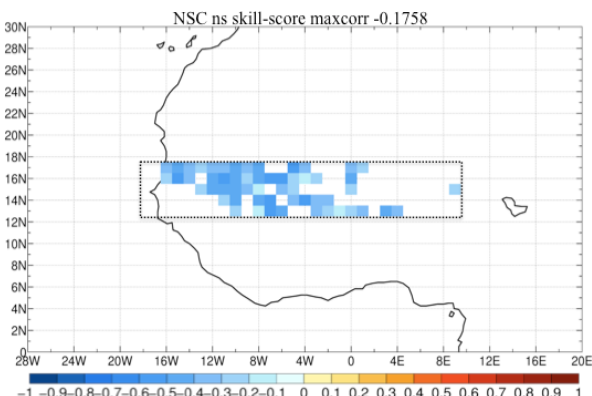
Figure 6. Skill-score validation using Pearson correlation coeffi- cients between observations and hindcasts for each point in space corresponding to NSC period. Significant values are plotted from a 90% statistical significance under a Monte Carlo